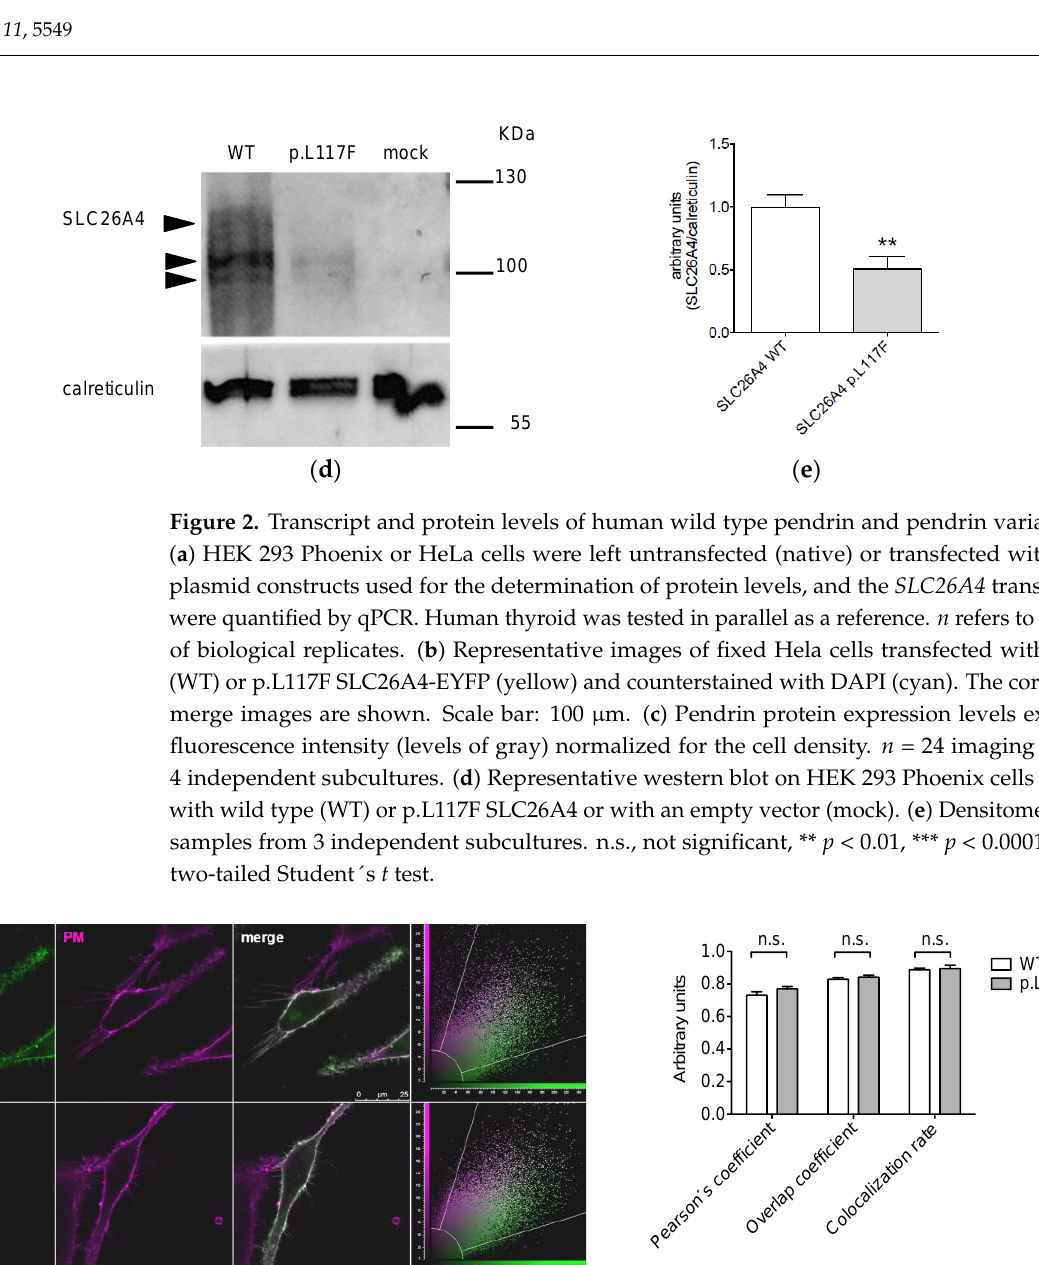
Figure 3. Colocalization of human wild-type pendrin and pendrin variant p.L117F with the plasma membrane. ( a ) Representative images of living Hela cells transfected with wild type (WT) or p.L117F SLC26A4 -EYFP (green) and stained with the plasma membrane (PM) marker CellMask TM Deep Red (magenta). The corresponding merge images and scatter plots are shown. Scale bar: 25 μm. ( b ) Average Pearson ’ s correlation coefficient, overlap coefficient, and colocalization rate. n re- fers to the number of cells from 3 independent subcultures. n.s., not significant, unpaired, two-tailed Student´s t test.